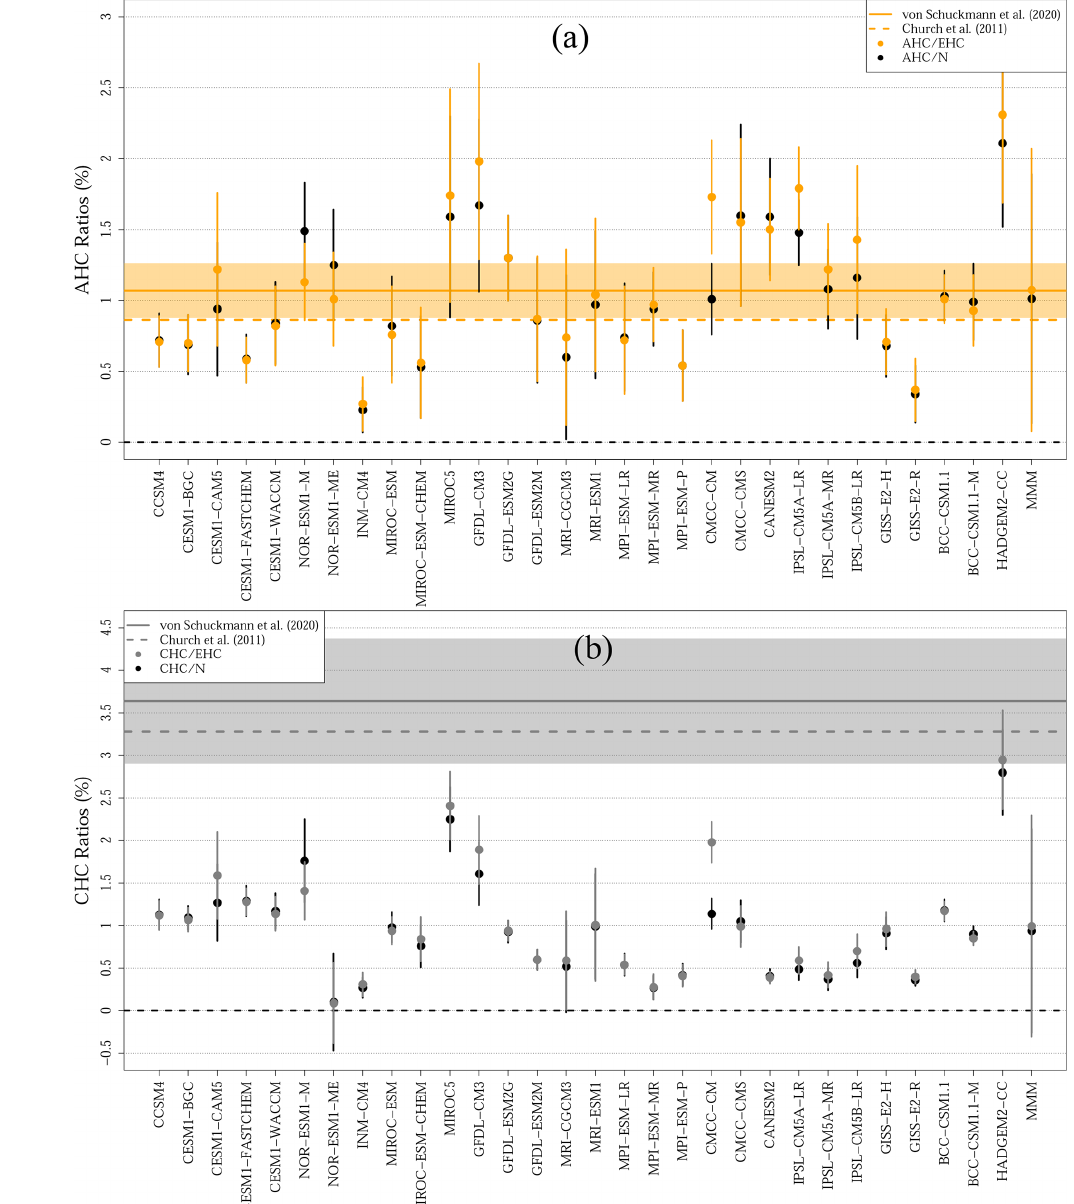
Figure 5. (a) Simulated proportion of heat within the atmosphere for the period 1972–2005CE using EHC (orange dots) and N (black dots) as estimates of total heat content in the climate system. (b) Simulated proportion of heat within the continental subsurface for the period 1972– 2005CE using EHC (light blue dots) and N (black dots) as estimates of total heat content within the climate system. Observations from von Schuckmann et al. (2020) are shown as solid horizontal lines and shadows (means and 95% confidence intervals), and observations from Church et al. (2011) are displayed as dashed horizontal lines. Multimodel means and 95% confidence intervals are indicated in the right side of the panels (MMM). The black dashed line indicate the 0%